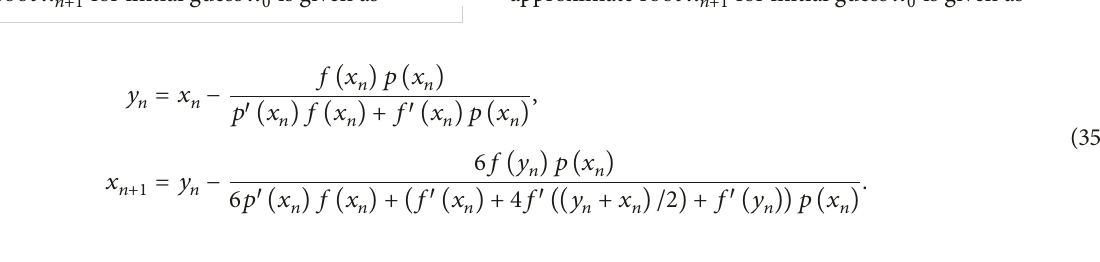
Algorithm 7. The iterative scheme which will compute the